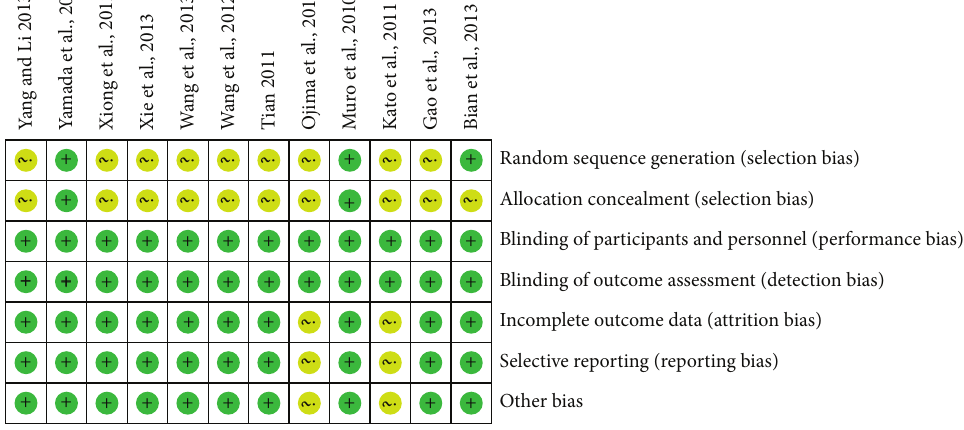
Figure 2: Risk of bias summary: review authors’ judgements about each risk of bias item for each included study.